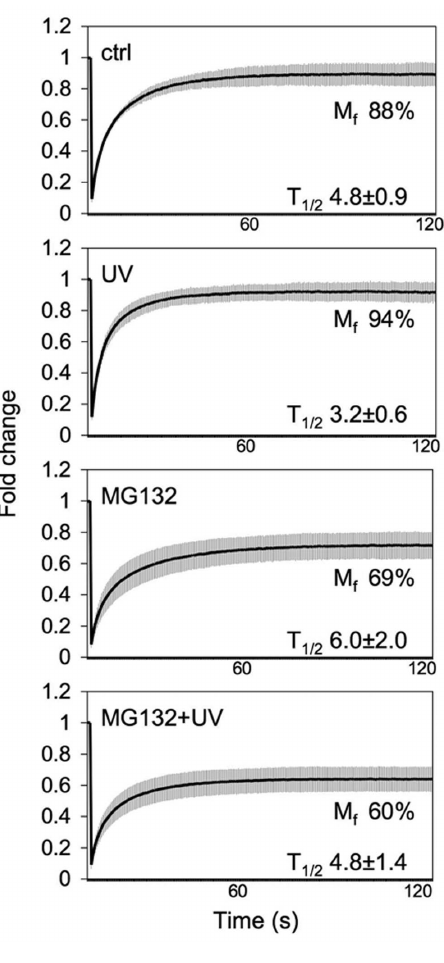
Figure 3. Nucleolar mobility of NPM is altered after protea- some inhibition and UV damage. U2OS cells stably expressing NPM-ECGFP were treated either with MG132 (10 m M) for 4 hours, UV (35 J/m 2 ), pretreated with MG132 for 1 hour followed by UV treatment (35 J/m 2 ) and incubation for 3 hours, or left untreated (control). Averages of normalized intensities, mobile fractions (M f ) and recovery half-times (T 1/2 ) from at least three independent experiments for each treatment are shown. Error bars, SD. N= 5–8 cells for each